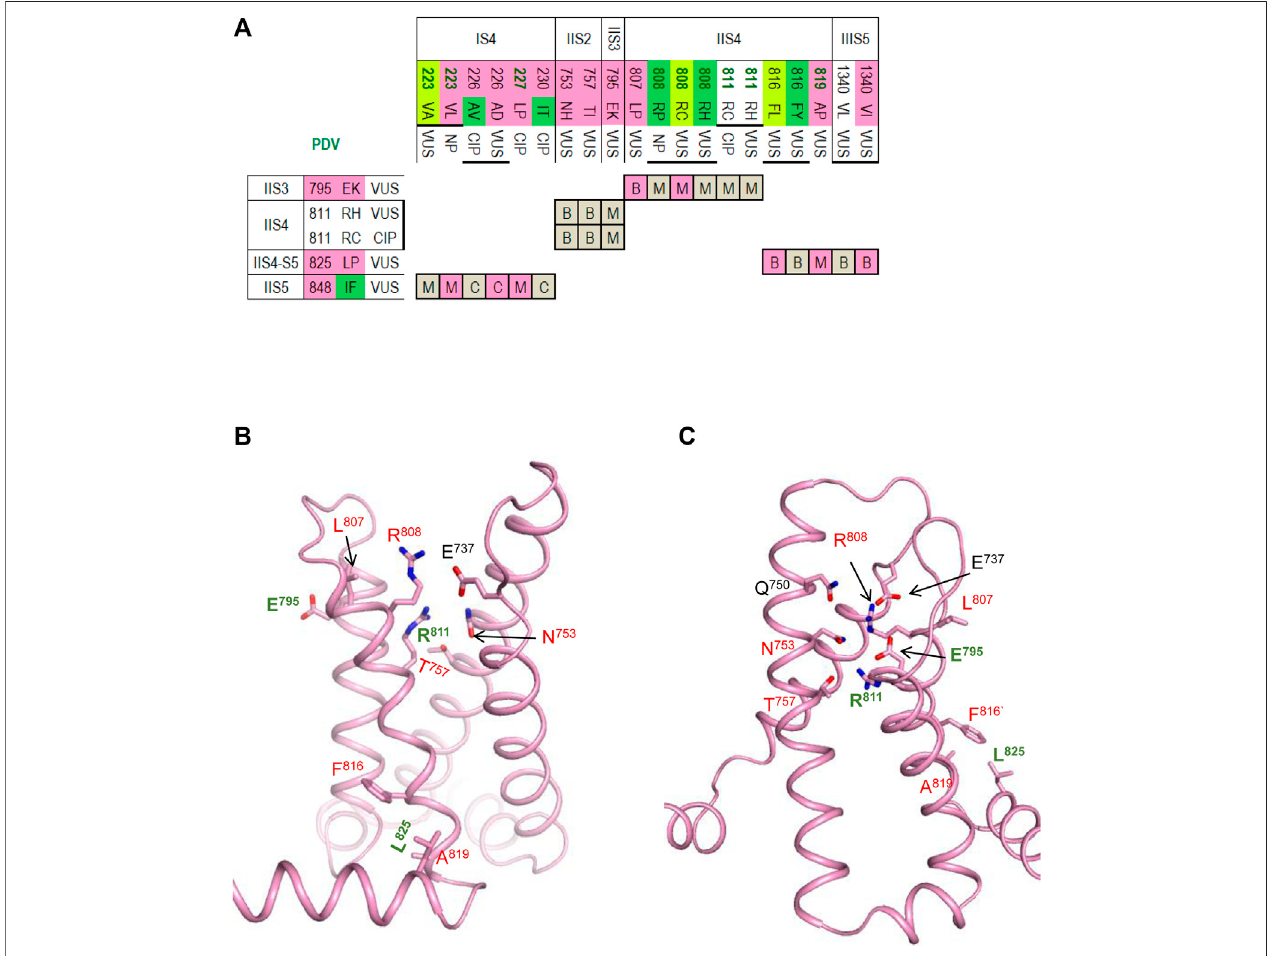
FIGURE6| VSD-IIintheactivated-statestructureandresting-statemodel. (A) Matrixofcontactvariants,inadditiontocontactswithinVSD-II,slowscontactsIIS4- 5/IIIS5 and IIS5/IS4 (B,C) VSD-II in the activated-state cryo-EM structure (B) and resting-state model (C) . Residues from set w54 and their contacts are indicated with green and red labels, respectively. VSD-II Section for more